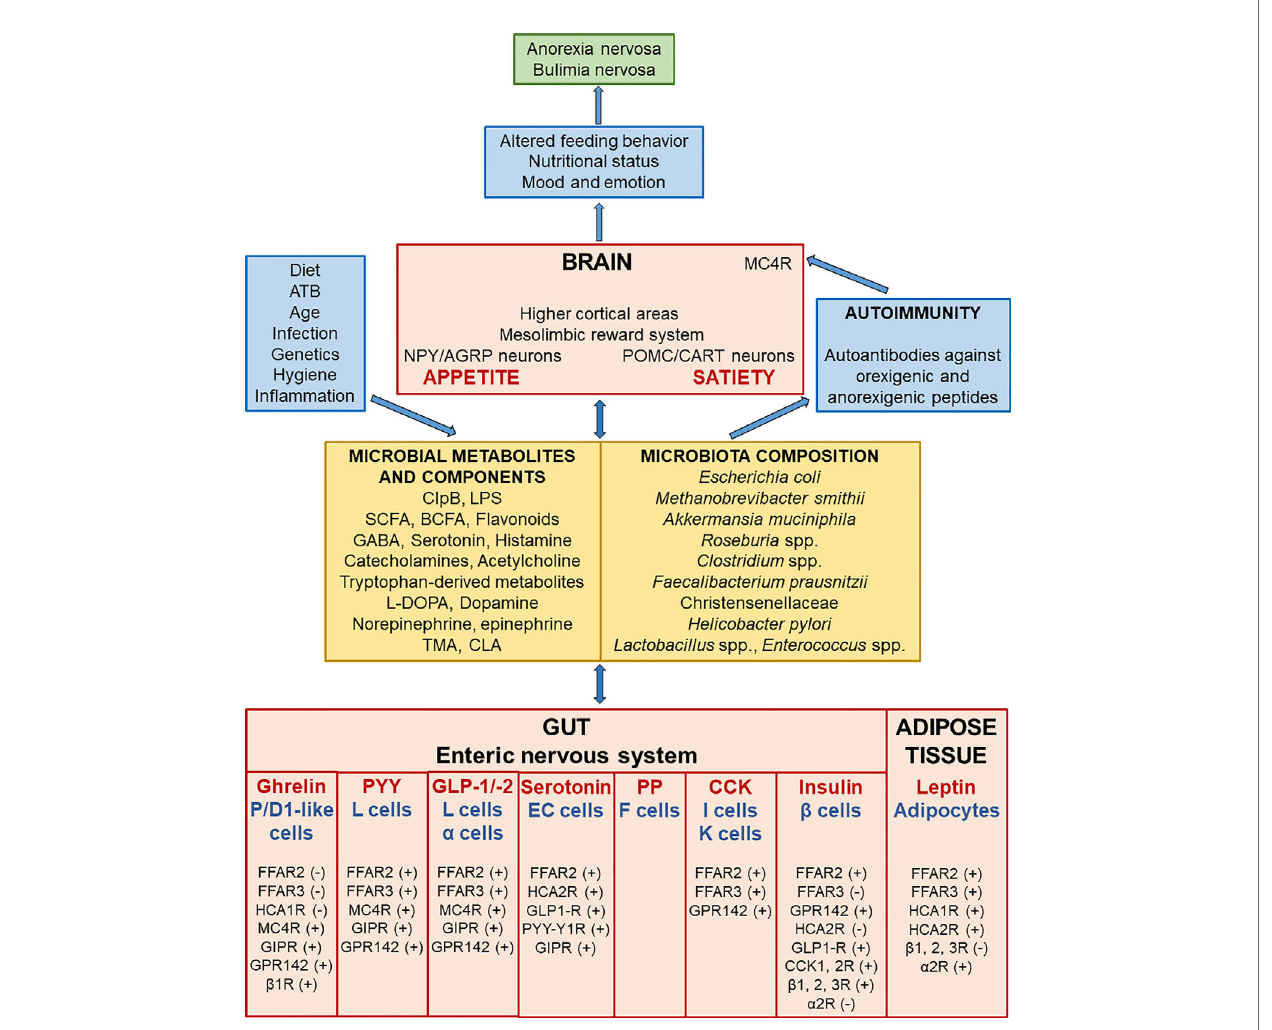
FIGURE 1 | Scheme demonstrating the bi-directional interactions along the adipose tissue, microbiome, gut and brain leading to the development of eating disorders. Microbial composition and consequently the amount of microbial metabolites and components are affected by various factors like diet, antibiotics, infection and so on. Gut microbial metabolites and components act as signals to in fl uence enteric nervous system and adipose tissue responses through various receptors. P/D1 like ghrelin cells in humans (or termed X/A like ghrelin cells in rodents) are localized in the oxyntic mucosa of the gastric fundus and duodenum. Enteroendocrine L cells secrete PYY and GLP-1/-2 (and/or co-release GLP-1/-2 together with PYY) in the mucosa of the distal ileum and colon. F (or PP) cells, which secrete pancreatic polypeptide (PP) under cholinergic control, are localized in the periphery of pancreatic islets of Langerhans, and also expressed in the distal gut. Enteroendocrine I and K cells, which secrete CCK and glucose-dependent insulinotropic peptide (GIP), are located in the mucosa of the upper small intestine. Short-chain fatty (FFA2-3) and hydroxy-carboxylic (HCA1-2) acid receptors are expressed on gastric P/D1 like ghrelin cells, ileal L cells, pancreatic a cells, enterochromaf fi n (EC) serotonin cells, duodeno-jejuno-ileal I and K cells, pancreatic b cells, and adipocytes. The signalization leads to ghrelin secretion inhibition or produce PYY, GLP-1/-2, serotonin, CCK, insulin, and leptin production. Leptin, an adipocyte-secreted hormone, is an indicator of energy stores and acts to reduce food intake and increase energy expenditure. These appetite-regulating hormones signal to NPY/AGRP and POMC/CART neurons, the mesolimbic reward system, and higher cortical areas, which all play a pivotal role in the regulation of metabolism. GABA has an inhibitory input from NPY/AGRP neurons to POMC/CART neurons in the hypothalamic arcuate nucleus. Activation of hypothalamic NPY/AGRP neurons stimulates hunger and inhibits energy expenditure and lipolysis in AT; however, stimulation of hypothalamic POMC/CART neurons together with MC4R leads to inhibition of food intake and enhancing of energy expenditure and lipolysis in AT. IgG immune complexes with orexigenic and anorexigenic peptides chronically activate MC4R leading to increased satiety in both AN and BN. Dysregulation of appetite-regulating circuits may affect altered feeding behavior leading to the onset, development, and maintenance of AN and BN. a 2R, alpha-2 adrenoceptors; AGRP, agouti-related protein; AT, adipose tissue; b 1, 2, 3R, beta-1, 2, 3 adrenoceptors; BCFA, branched-chain fatty acids (isobutyrate, 2-methyl-butyrate, and isovalerate); ATB, antibiotics; CART, cocaine- and amphetamine-regulated transcript; CCK, cholecystokinin, CCK1, 2 R; cholecystokinin 1, 2 receptors; CLA, conjugated linoleic acid; ClpB, enterobacterial caseinolytic protease B; EC, enterochromaf fi n serotonin cells; FFAR, free fatty acid receptor; GABA, gamma- aminobutyric acid; GIP, glucose-dependent insulinotropic peptide; GIPR, glucose-dependent insulinotropic peptide receptor; GLP-1/-2, glucagon-like peptide-1 and 2; GLP1-R, glucagon-like peptide-1 receptor; GPR142, G protein receptor 142 for tryptophan, HCAR, hydroxy-carboxylic acid receptor; L-DOPA, L-3,4- dihydroxyphenylalanine; LPS, lipopolysaccharide; MC4R, melanocortin 4 receptor; NPY, neuropeptide tyrosine; POMC, pro-opiomelanocortin; PP, pancreatic polypeptide; PYY, peptide tyrosine tyrosine; PYY-Y1R, peptide tyrosine tyrosine-1 receptor, SCFA, short-chain fatty acids (butyrate, acetate, and propionate); TMA, trimethylamine; (+) = the stimulatory effect of ligands on hormone or serotonin secretion; (-) = the inhibitory effect of ligands on hormone